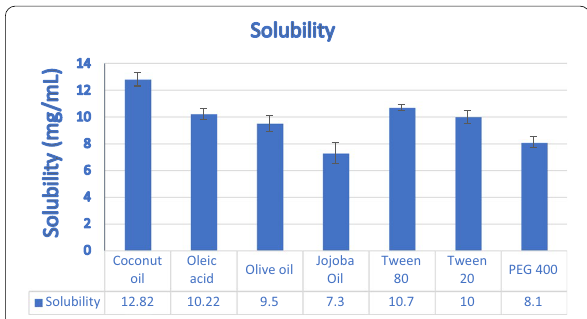
Fig. 1 Solubility of MEL in oils, surfactants and co‑surfactants, data expressed as mean SD ( n ± =